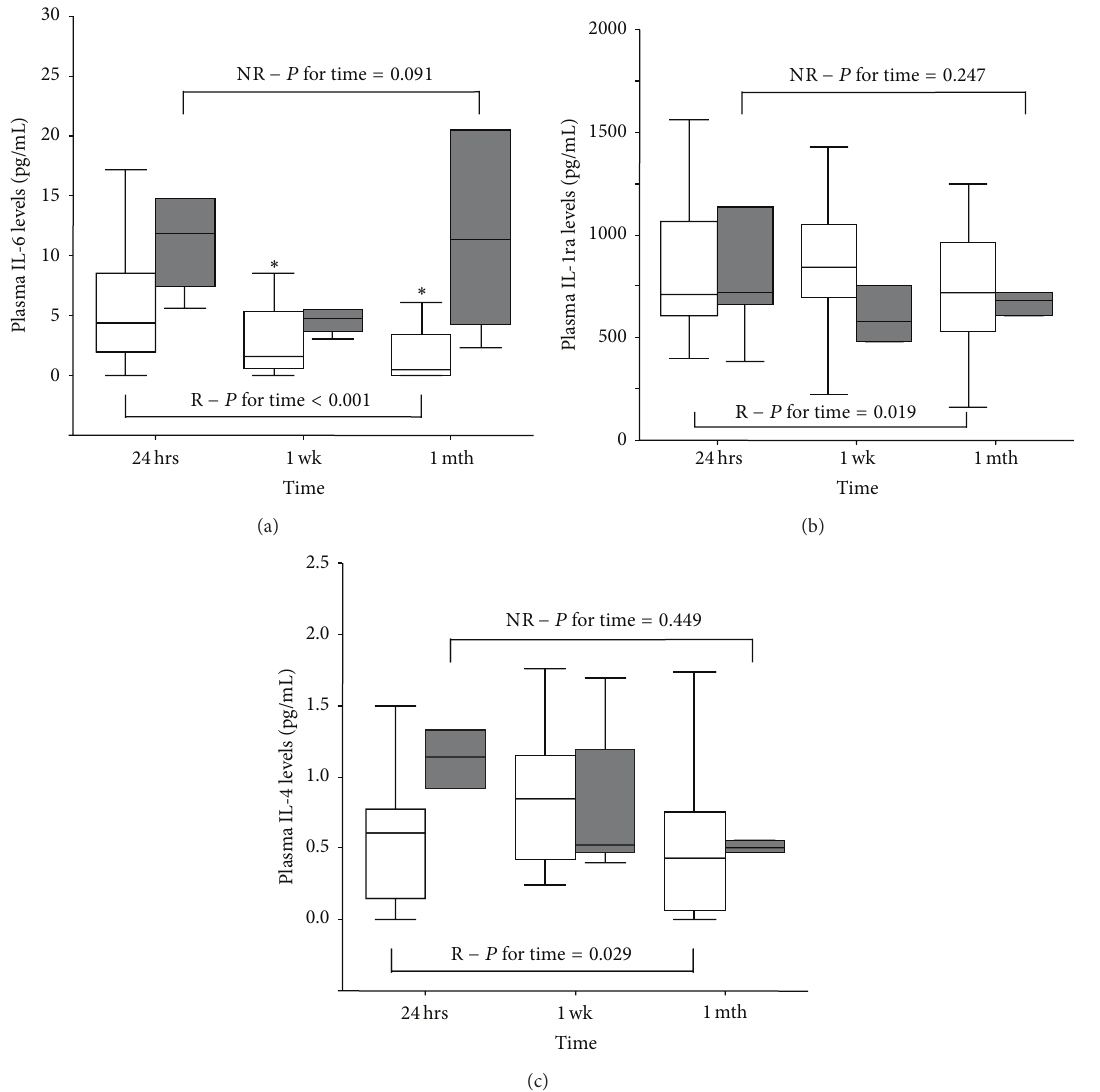
Figure 2: Profile of levels of IL-6 (a), IL-1ra (b), and IL-4 (c) in NR and R patients (R: empty box-plots; NR: dark box-plots). 𝑃 for time refers to time-dependent changes (24 hours, 1 week, and 1 month) in groups assessed by nonparametric Friedman test, ∗ 𝑃 < 0.025 versus 24 hrs by Bonferroni adjusted post hoc test for pairwise